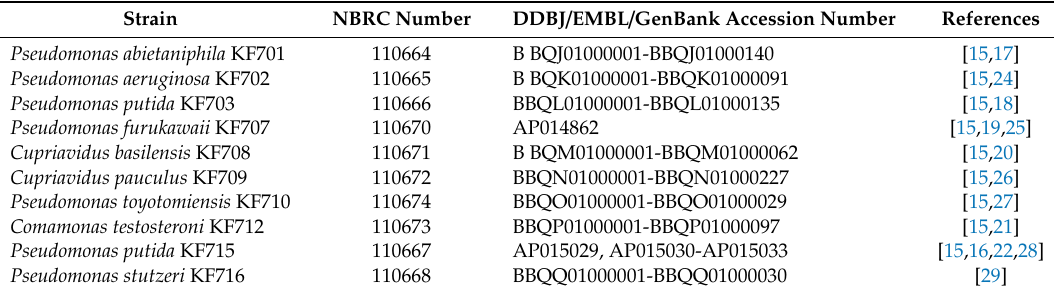
Table 1. Biphenyl / PCB degrading KF strains used in this study.